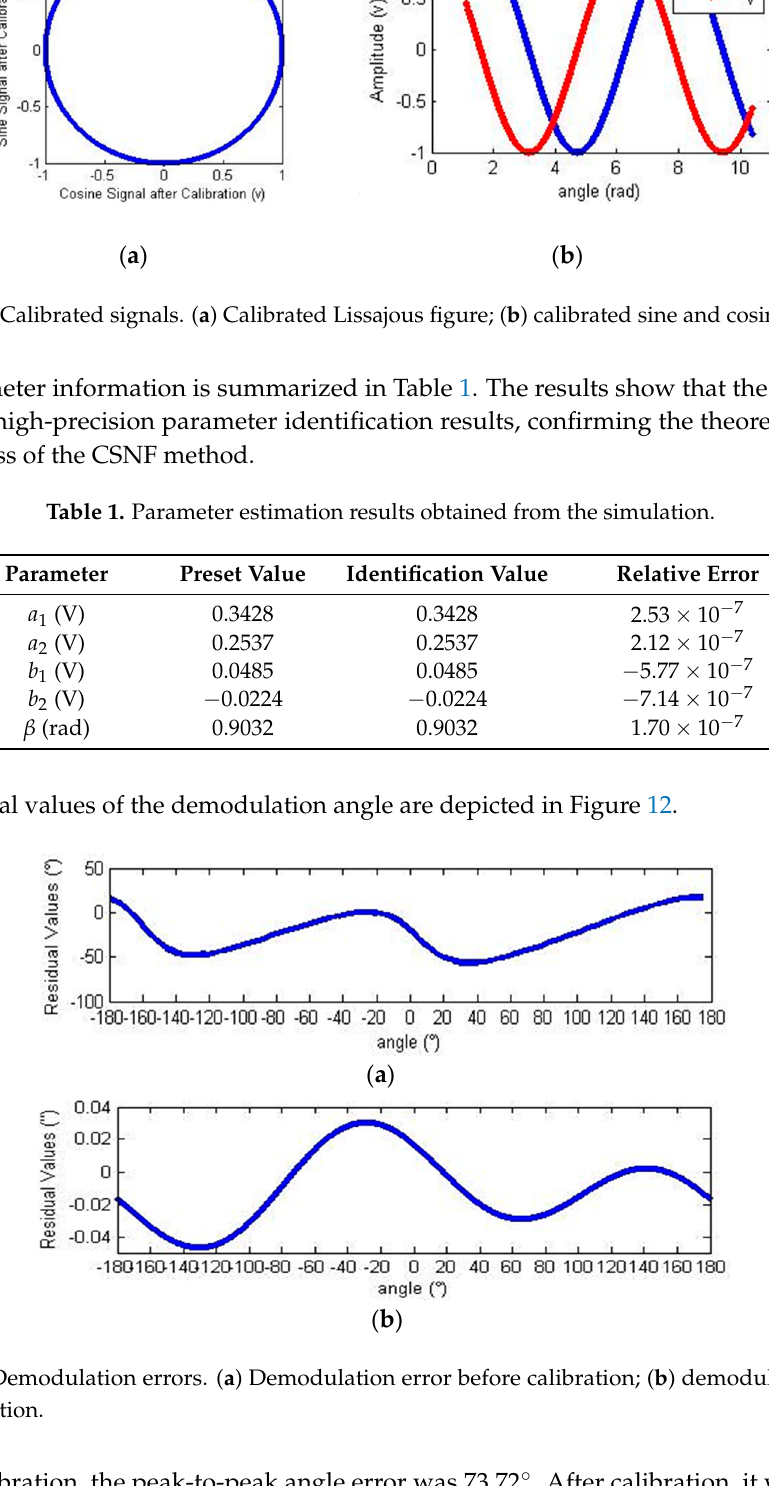
Figure 10. Estimation process. ( a ) Phase shift between two signals; ( b ) loss value during training.